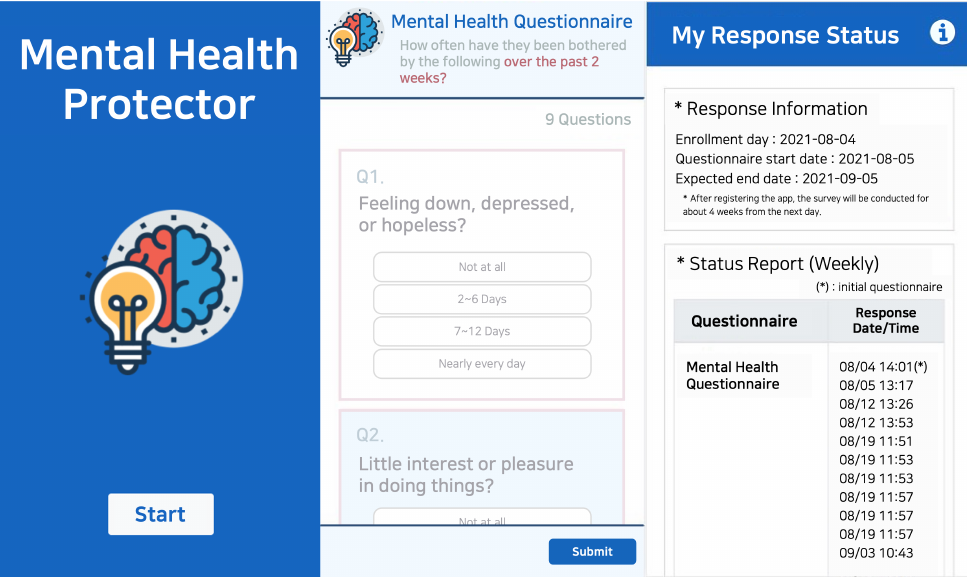
Figure 3. User Interface of “Mental Health Protector” application. The image shows a part of the data collection application titled “Mental Health Protector” execution screen. The image on the left depicts the initial execution screen, the image in the center depicts the screen that responds to the survey, and the image on the right represents the screen that can check the response